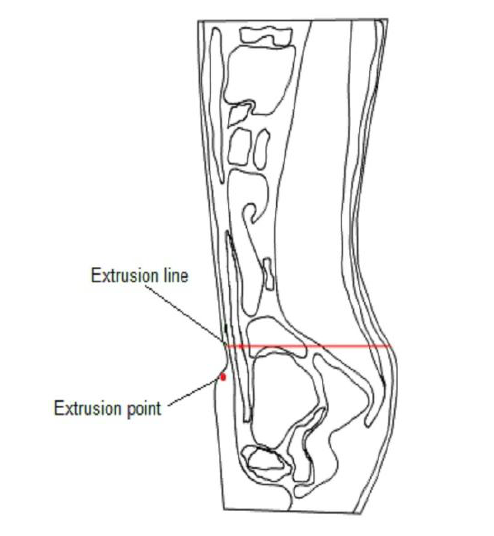
Figure 8: Extrusion line and point where temperature variations are analyzed Fig. 9 shows the temperature variations w.r.t. duration of exposure for different values of relaxation time. These changes are studied at extrusion point for exposure power densities of 1 mW cm -2 , 5 mW cm -2 , and 50 mW cm -2 .